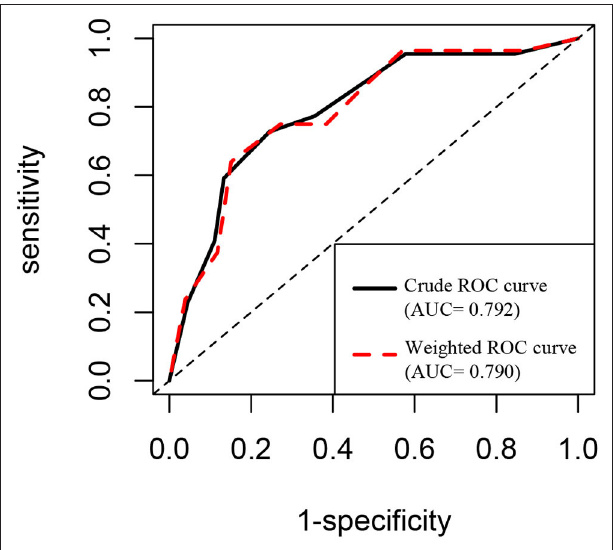
FIGURE 3 | ROC curve analysis of CEA levels in distinguishing moderate cases from discharged COVID-19